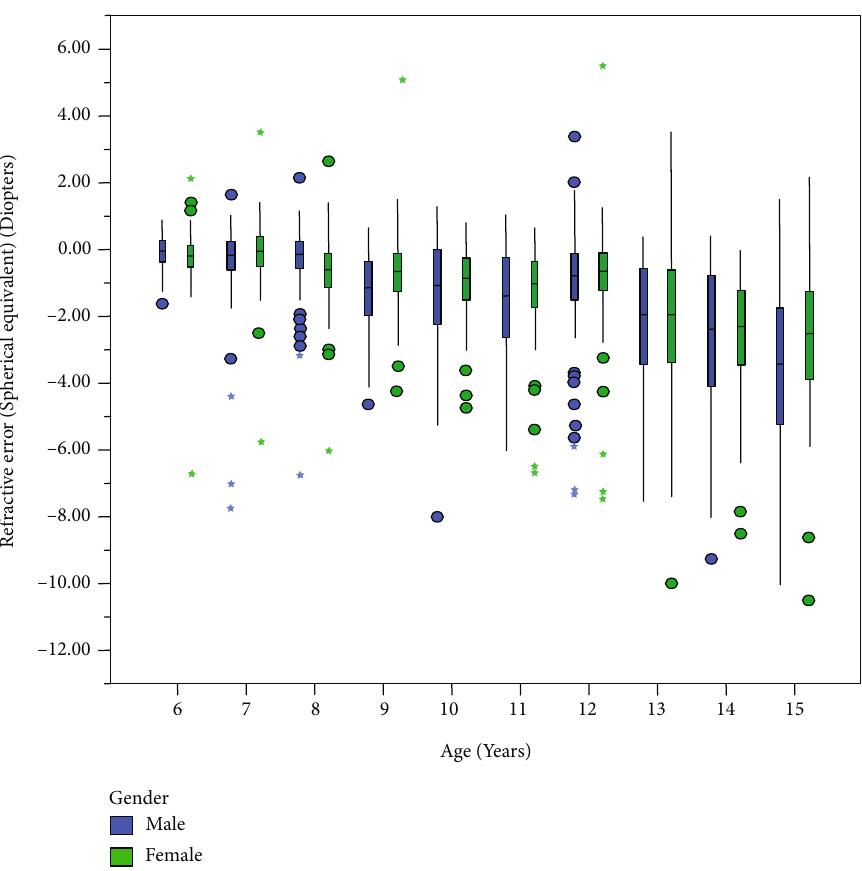
Figure 2: Distribution of refractive errors (spherical equivalent) of the right eyes, strati fi ed by age and